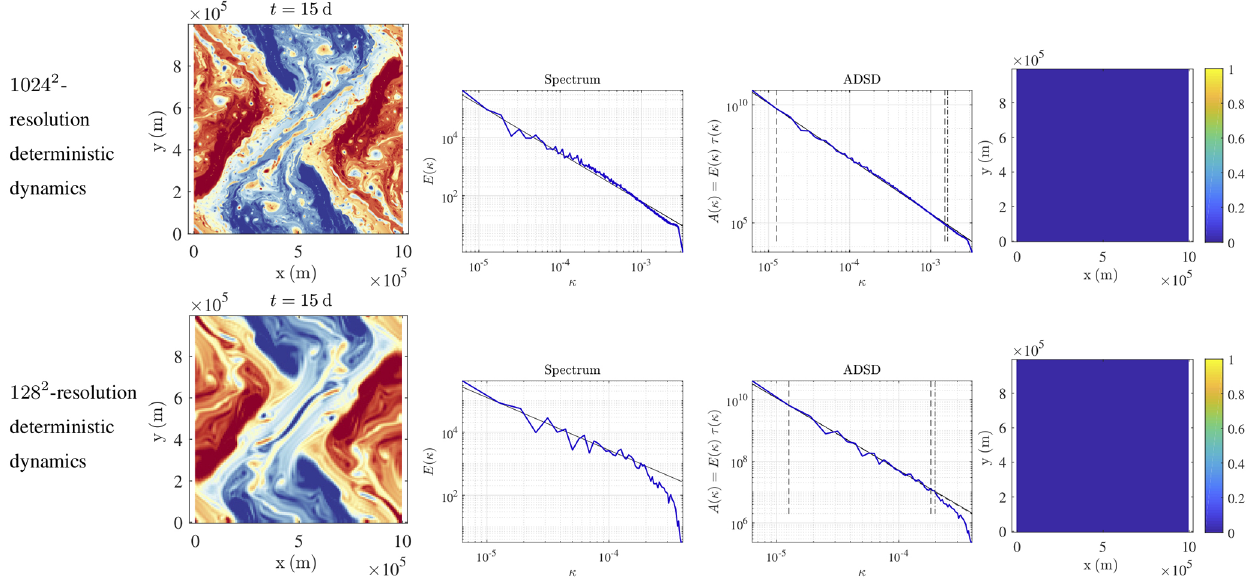
Figure 3. Presented from left to right are the buoyancy field (ms − 2 ), KE spectrum (m 2 s − 2 / (radm − 1 )), ADSD (m 2 s − 1 / (radm − 1 )), and variance tensor at t = 15d for (from top to bottom) a 1024 2 -resolution deterministic dynamics and a 128 2 -resolution deterministic dynamics. This particular initial condition corresponds to case 2 studied by Constantin et al. (1994, 1999, 2012) at a resolution of 128 2 . The low- resolution deterministic dynamics shows too many filaments and not enough